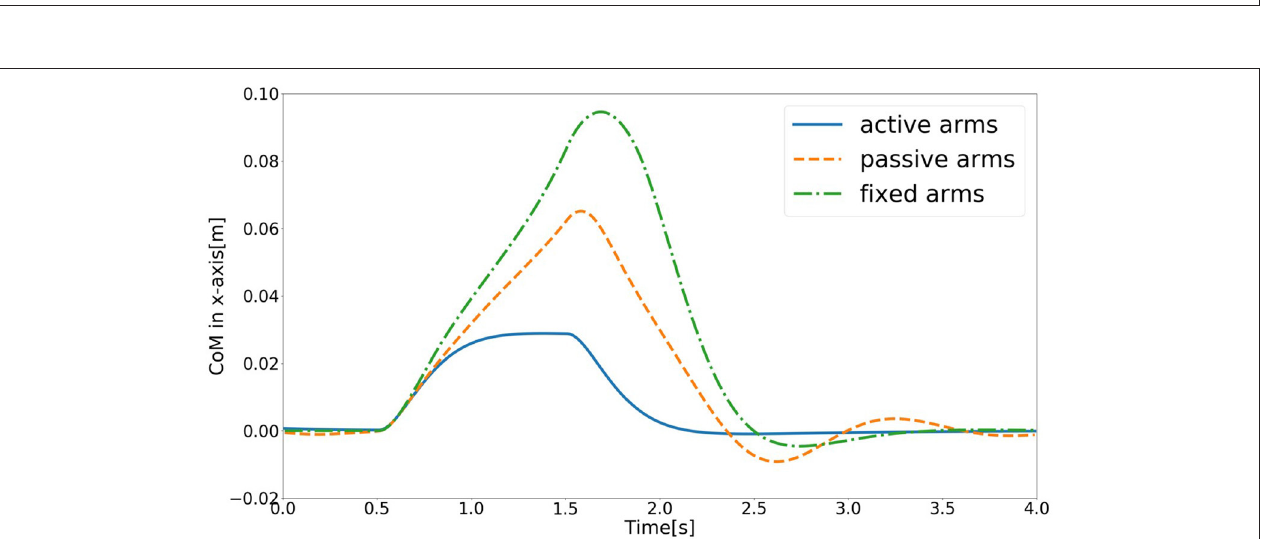
Frontiers in Neurorobotics |